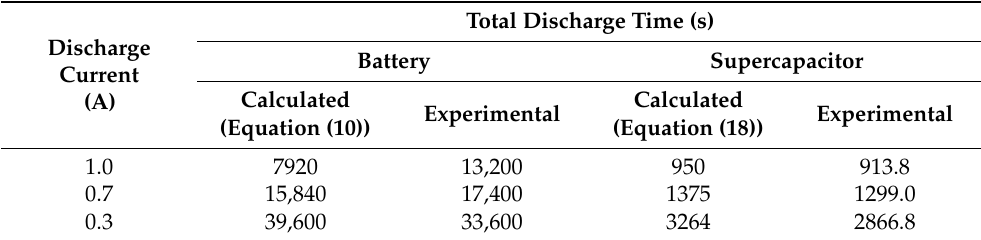
Table 3. Discharge time of LiPo battery and